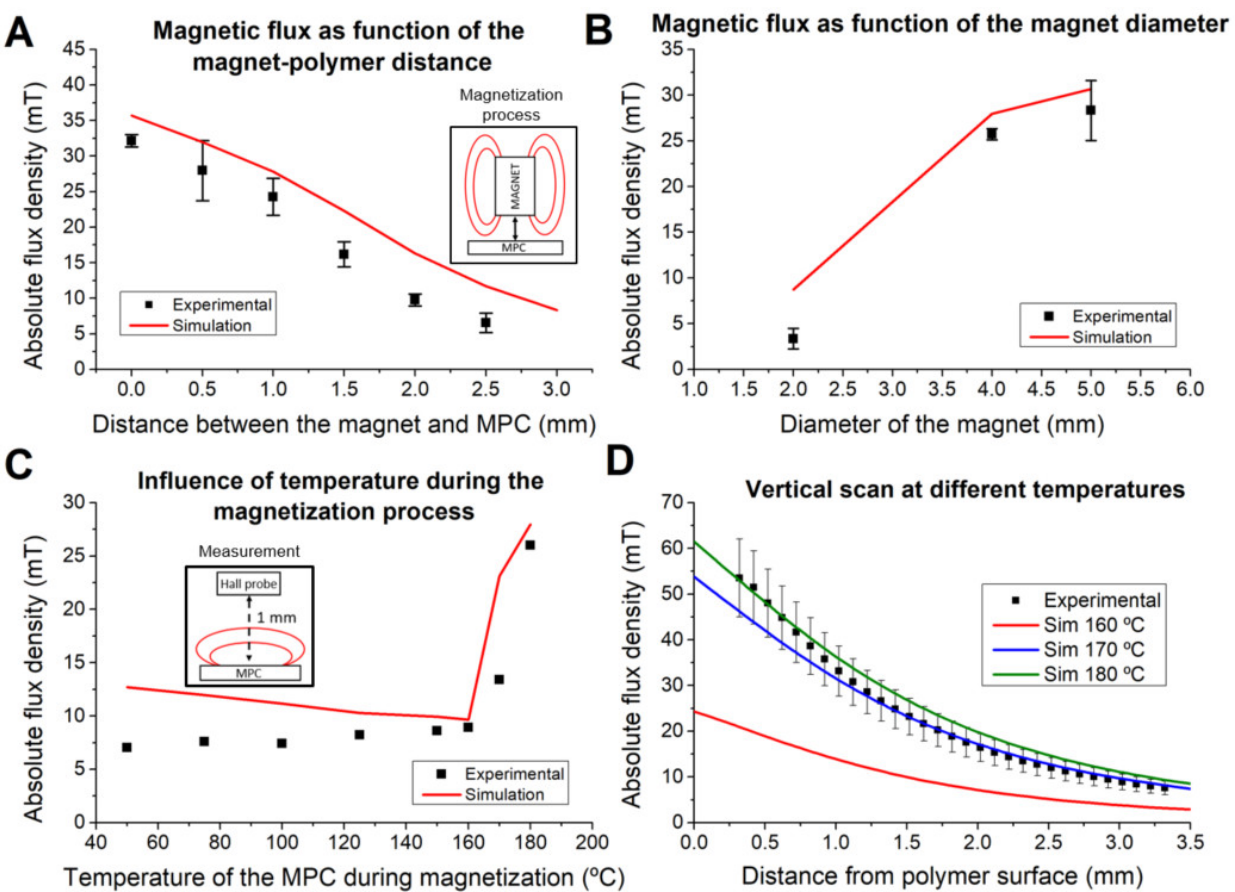
Figure 5. Characterization of different variables influencing the magnetization process: ( A ) influence of the distance between the magnet and the polymer during the magnetization process; ( B ) influence of the diameter of the magnet used for the magnetization; ( C ) influence of the temperature of the polymer during its magnetization; ( D ) vertical scan from the surface of the magnetic part: measured values vs. simulations at different temperatures—160 °C ( A ), 170 °C ( B ) and 180 °C ( C ).